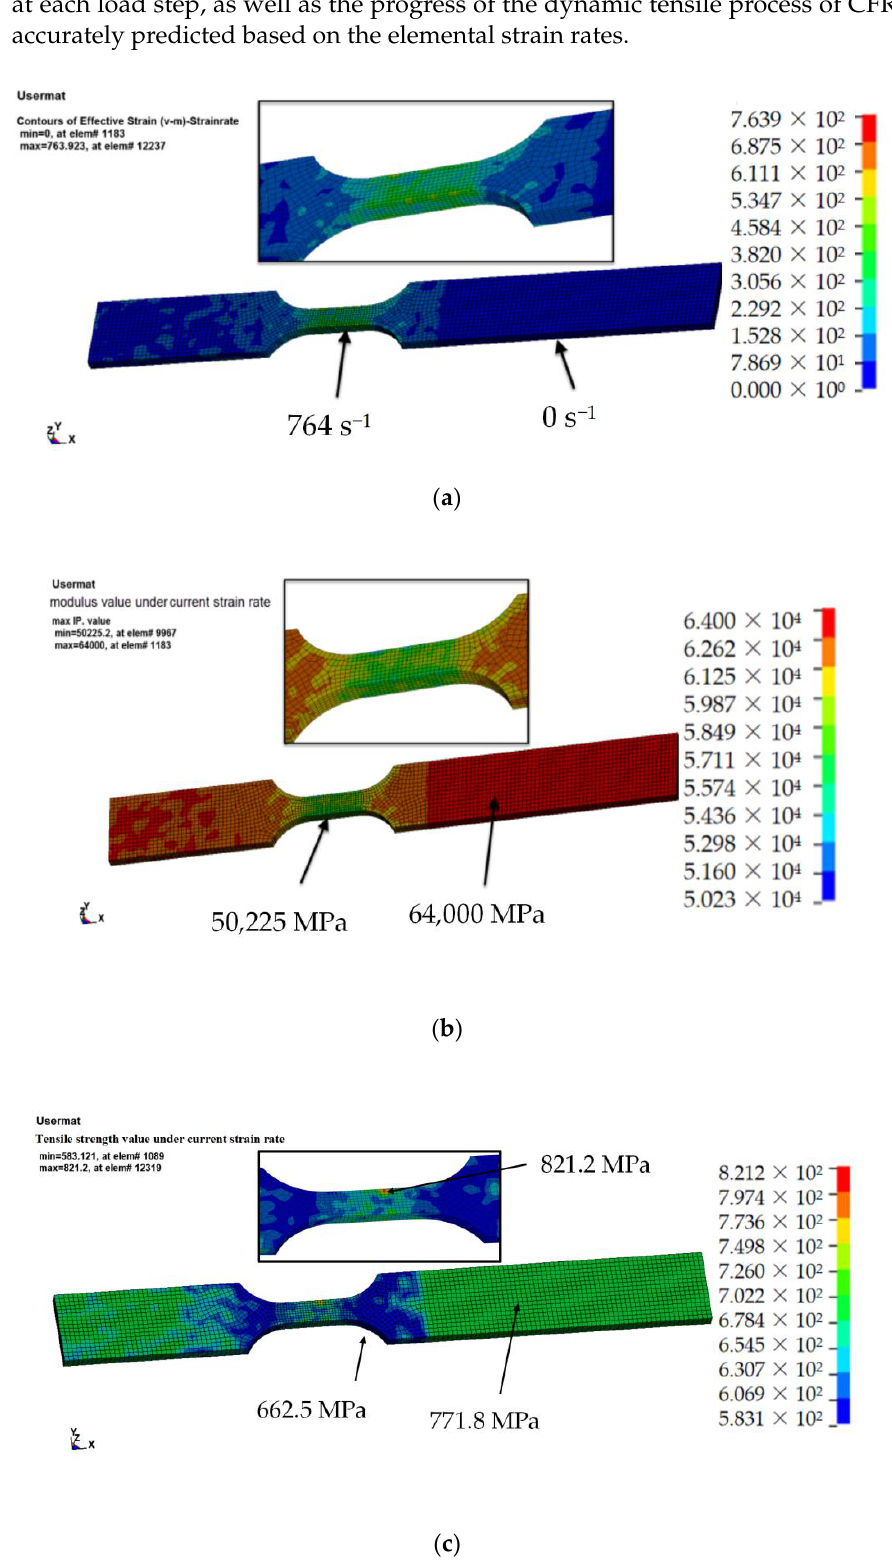
Figure 9. Contour maps showing the distribution of the ( a ) strain rate, ( b ) modulus, and ( c ) strength across the finite element model.